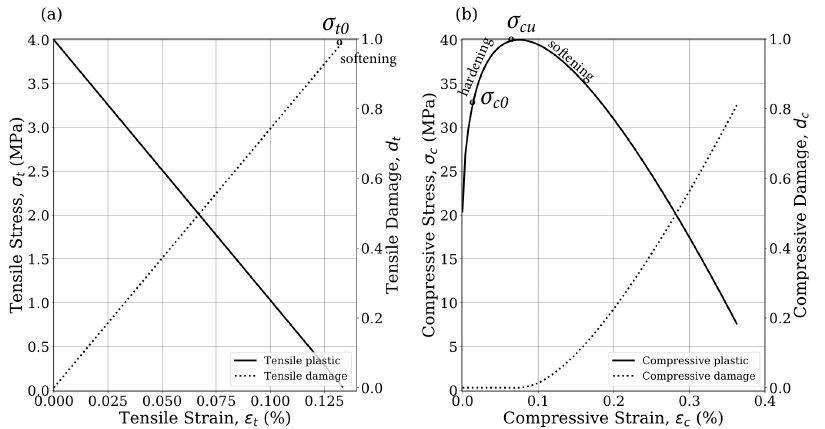
Figure A2. Input material properties for the Concrete Damaged Plasticity (CDP) model. The response of the CDP model for ( a ) uniaxial tensile loading and ( b ) uniaxial compressive loading are